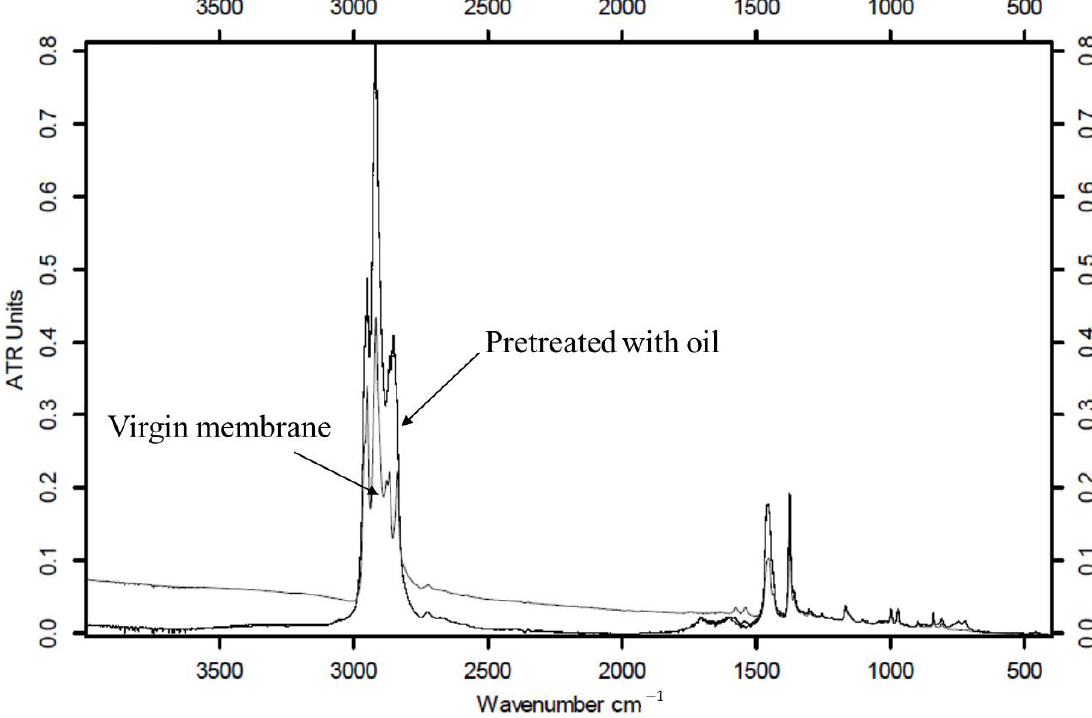
Figure A4. FTIR spectra of virgin and pretreated with oil membrane.